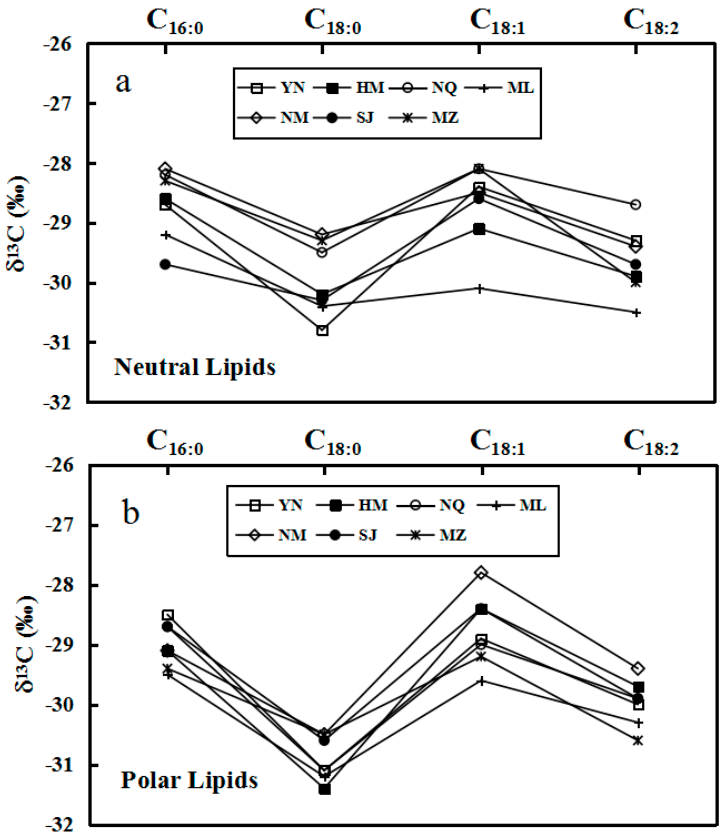
Figure 2. Variation of the stable carbon isotope ratios ( δ 13 C) of fatty acids C 16:0 , C 18:0 , C 18:1 , and C 18:2 in the neutral ( a ) and polar ( b ) lipids from wild Ophiocordyceps sinensis.